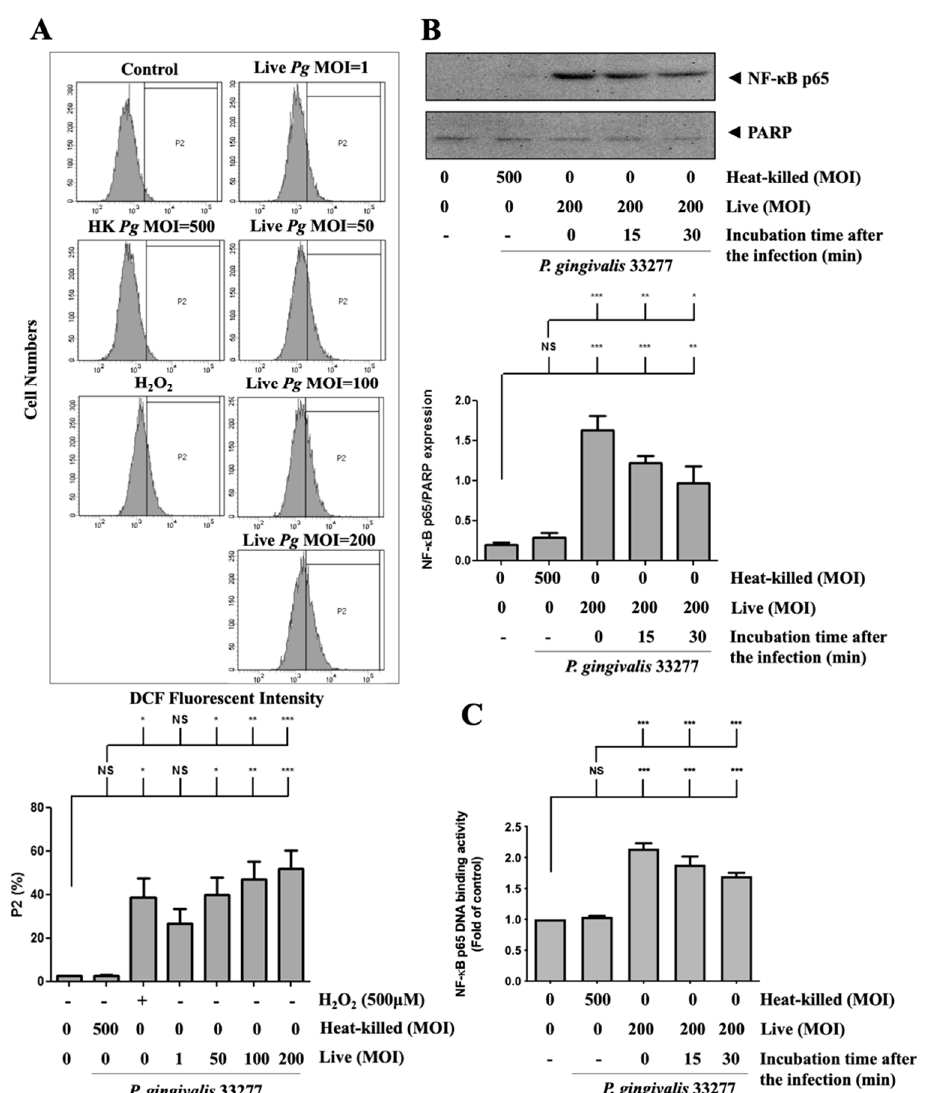
Figure 5. P. gingivalis stimulated the production of reactive oxygen species (ROS) and increased NF- κ B activation in brain endothelial cells. ( A ) bEnd.3 cells are pre-incubated with DCFH-DA (50 µ M) for 30-min. After several washes, cells are treated with various MOI (1, 50, 100, or 200) of P. gingivalis or heat-killed bacteria (MOI of 500) for 90-min. ROS production is determined by the DCF fluorescence intensity using a flow cytometer. Treatment with hydrogen peroxide (H 2 O 2 ; 500 µ M) is a positive control. The quantitative percentage of the P2 area is shown in a low panel. bEnd.3 cells are infected with P. gingivalis (200 MOI) for 90 min followed by further incubation with fresh medium for the indicated time periods (15 or 30 min). The nuclear fraction of NF- κ B p65 protein is determined by Western blotting analysis ( B ). The NF- κ B p65 DNA-binding activity was determined by the transcription factor binding assay ( C ). Data in the bar graph are presented as mean values ± SEM ( n = 4). Significant differences of the control and heat-killed P. gingivalis groups are expressed as *, p < 0.05; **, p < 0.01; ***, p < 0.001; NS, p > 0.05.